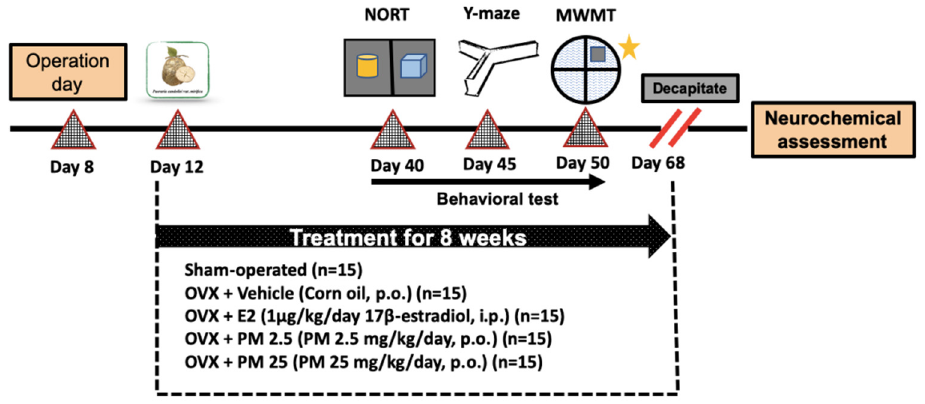
Figure 4. A schematic representation of the experiment